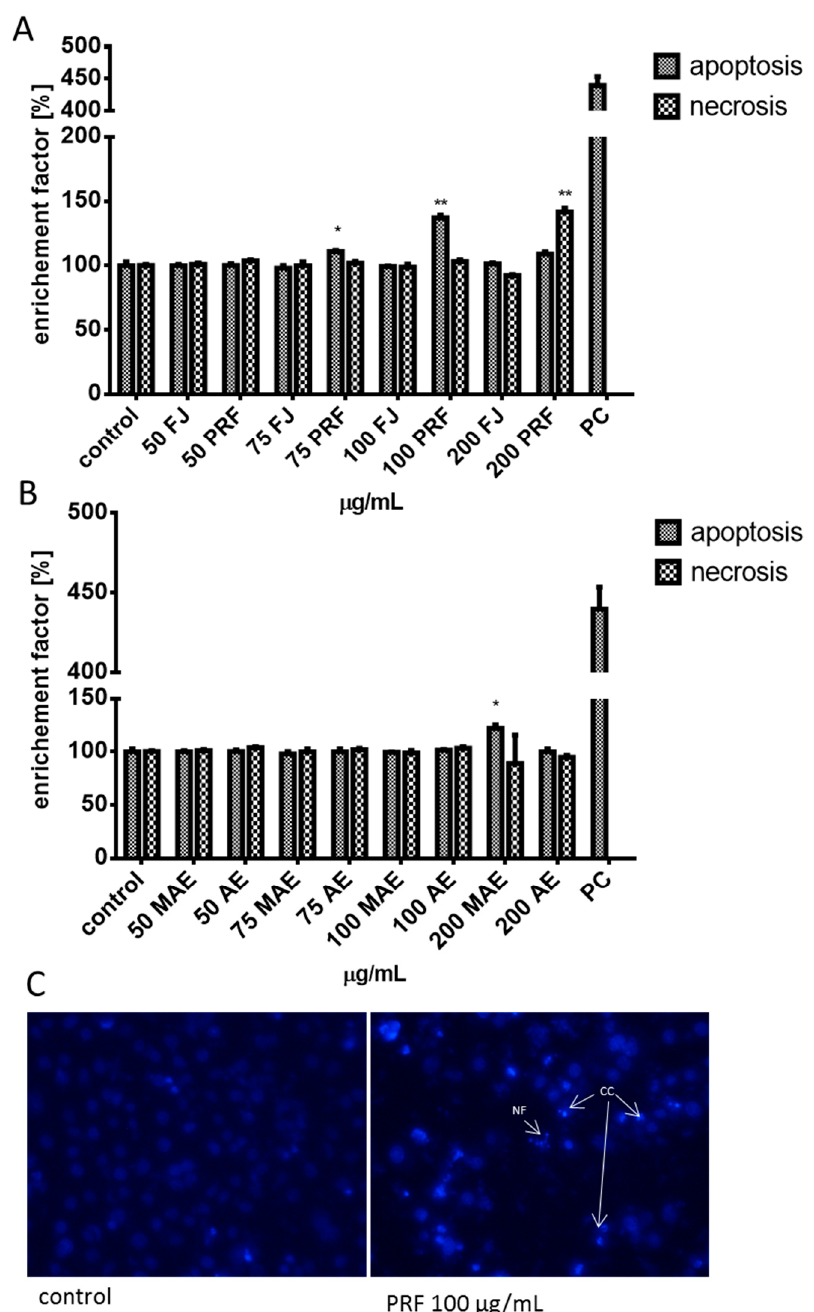
Figure 10. The influence of 24 h of exposure of juice (FJ) and PRF (phenolic rich fraction) ( A ), MAE (methanol-acetone extract) and AE (acetone extract) ( B ) on DNA fragmentation (late stage of apoptosis) analyzed by Cell Death Detection kit, PC—internal positive control of assay; nuclear morphology of DAPI-stained Caco-2 cells after 24 h of exposure to PRF at 100 µ g / mL dosage. NF (nuclear fragmentation) and CC (chromatin condensation) in cells were observed ( C ) using fluorescence microscope (Nikon TS100 Eclipse, Japan), 200 × magnification. Images are representative of one of four similar experiments. Control cells were not exposed to any compound but the vehicle; values are means ± standard deviations from at least three independent experiments; statistical significance was calculated versus control cells (untreated) * p ≤ 0.05, ** p ≤